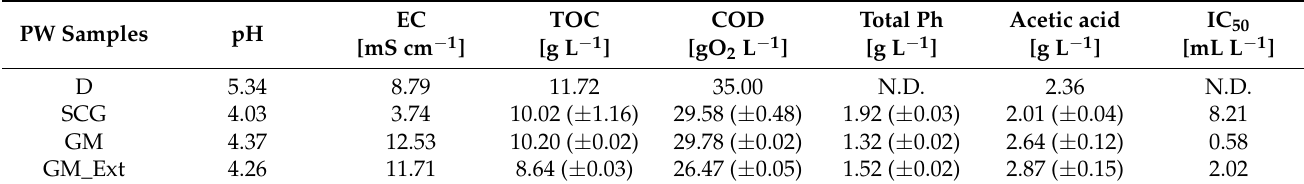
Table 3. Characterization of process water samples from the hydrothermal carbonization of the feedstocks (standard deviations in